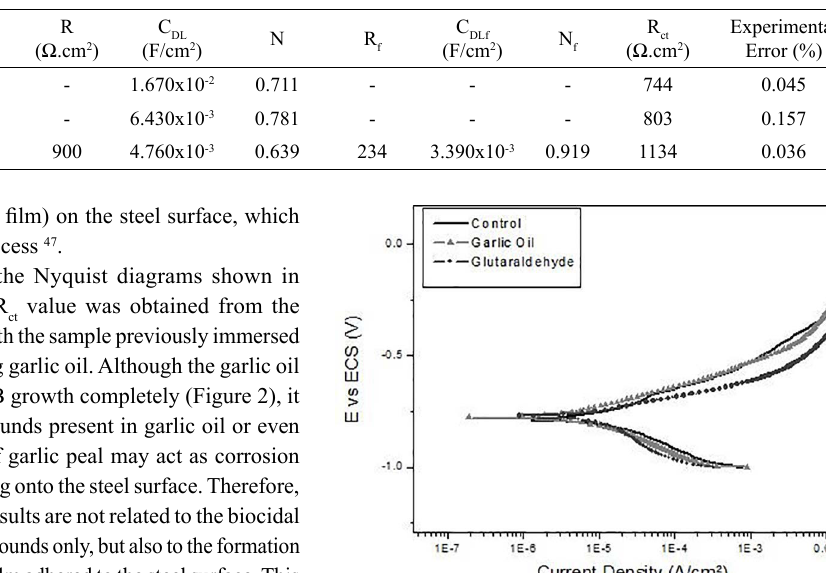
Table 1. Parameters obtained by simulating the EIS data for the 1020 carbon steel (previously incubated in SRB-containing culture medium in the absence and presence of the studied biocides) in synthetic seawater, using the equivalent electrical circuits presented in Figures 5b and 5c